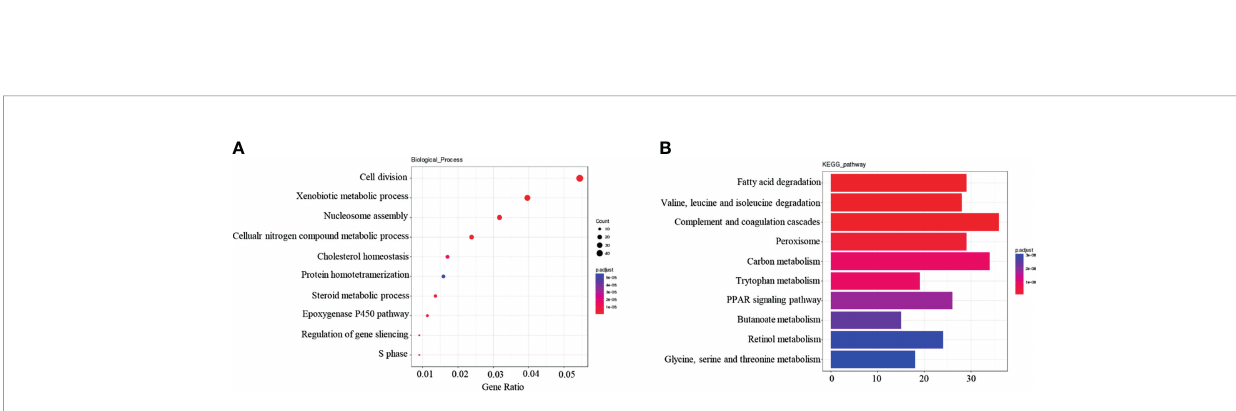
FIGURE 2 | Functional enrichment analysis of Dif-mRNAs: (A) Top 10 are enriched for Go-BP terms. (B) Top 10 enriched in KEGG